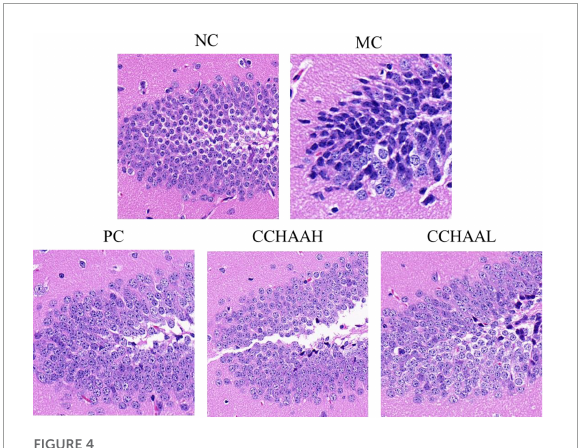
FIGURE4 The histopathological alterations in the hippocampal CA3 regions caused by